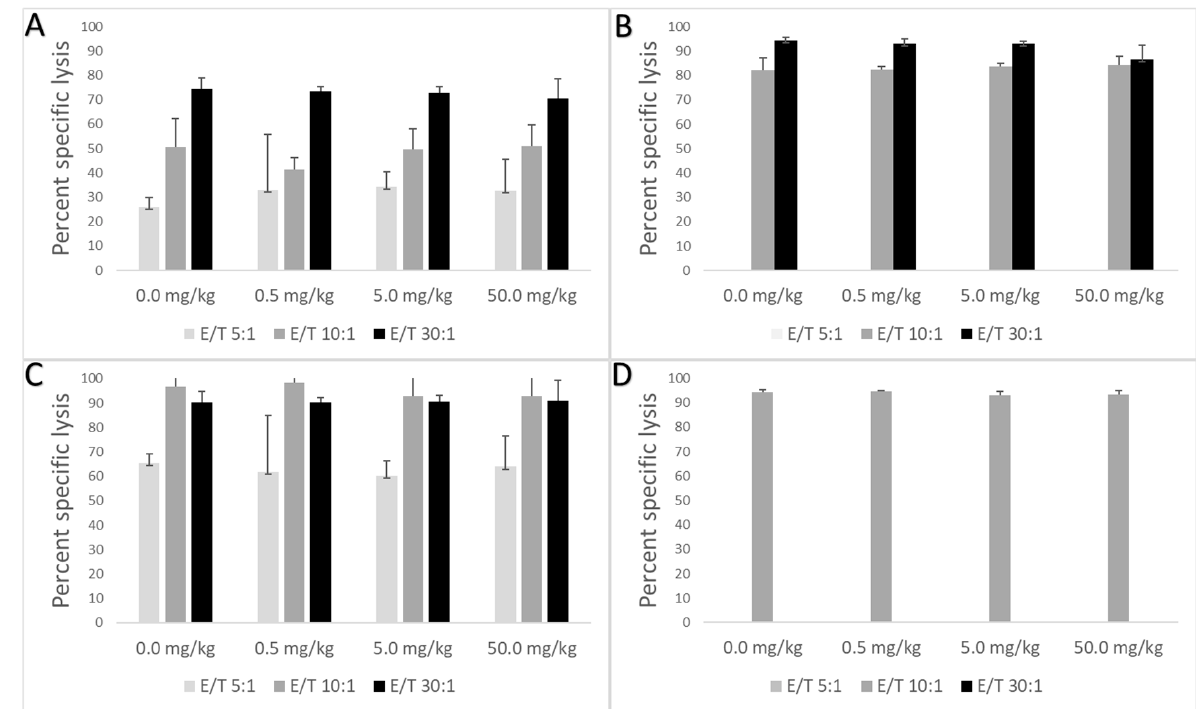
Figure 2. Mean percent specific lysis ( ± standard deviation) in male and female C57BL/6 mice orally exposed to PFMOPrA or PFMOBA for 30 days. Cells were analyzed by flow cytometry one day after dosing ended. ( A ): Male